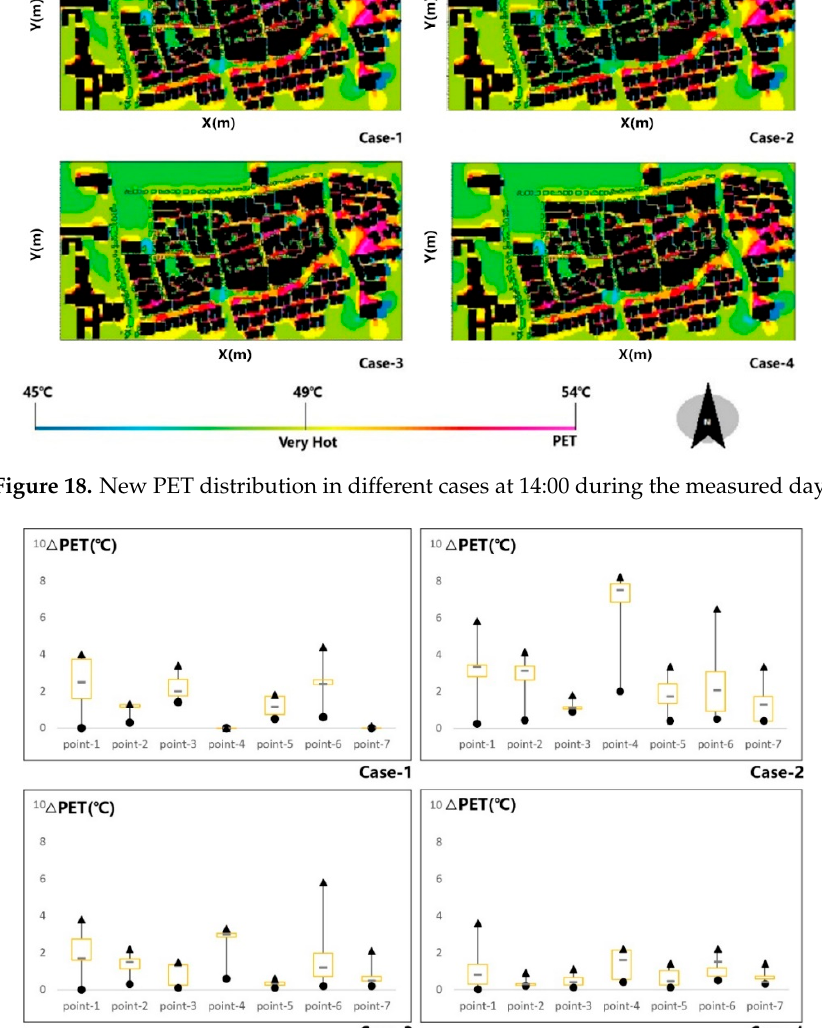
Figure 19. Cooling effect of the new cases at 14:00.